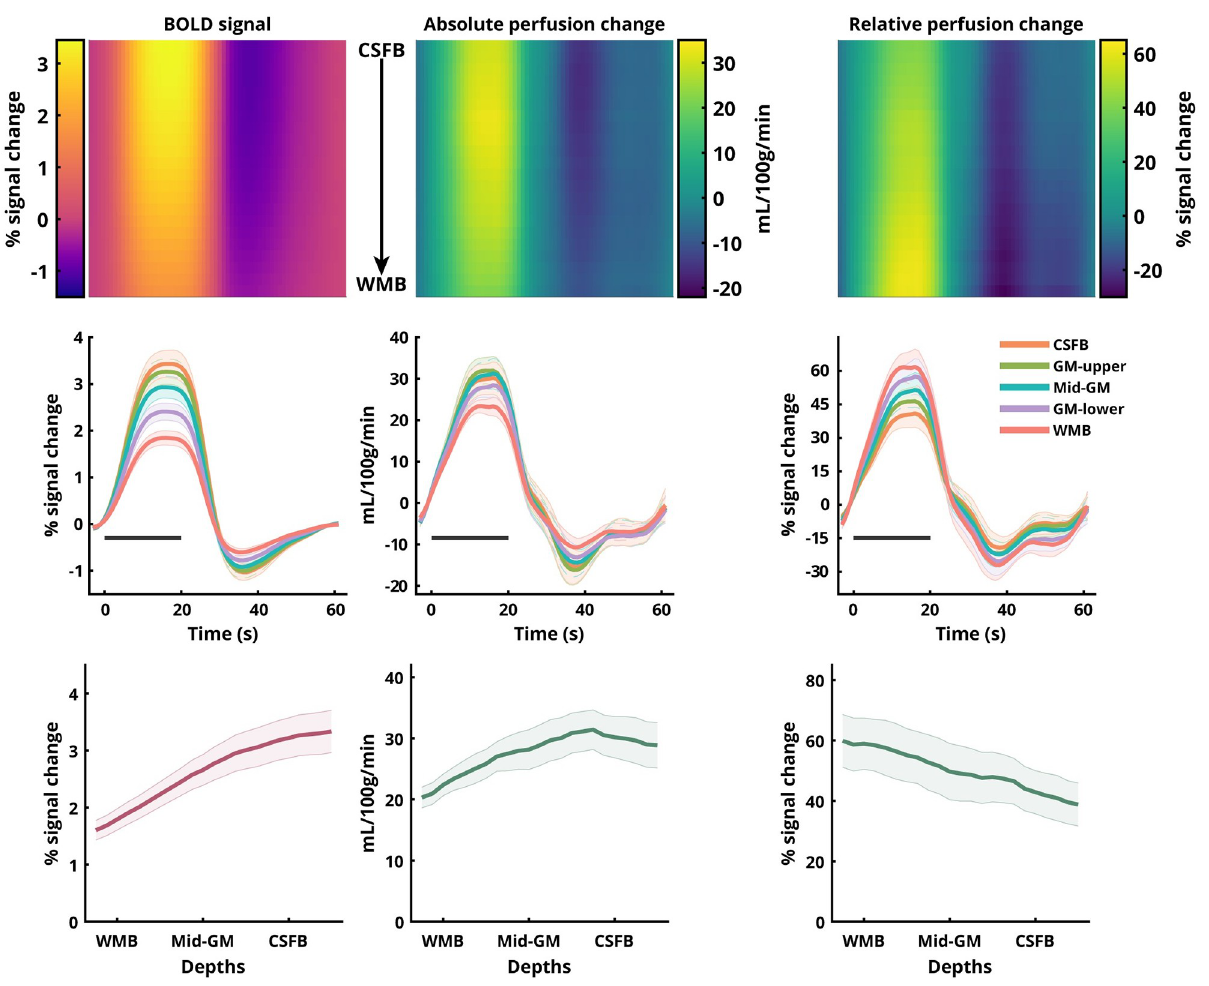
Fig 4. Same as Fig 3 for V2